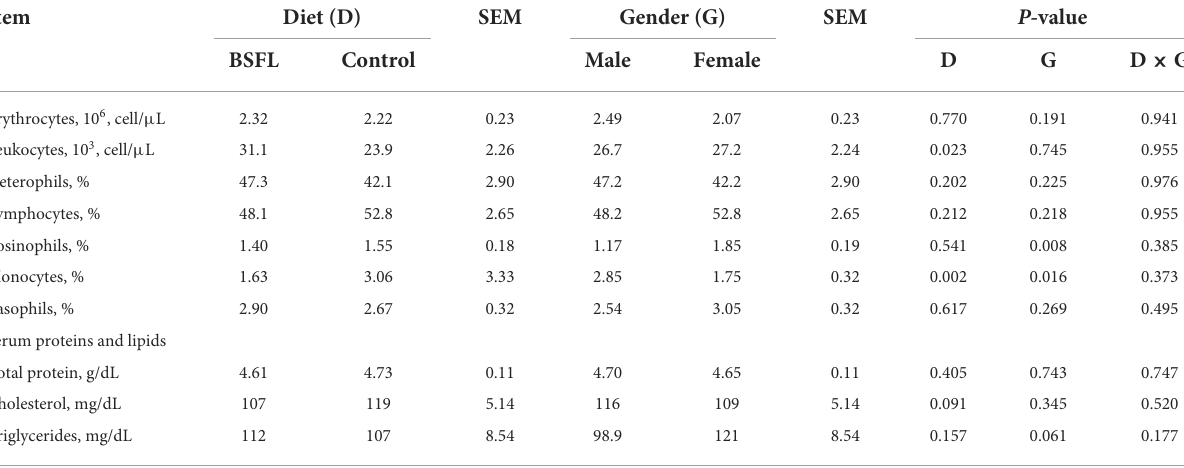
TABLE 5 The hematological traits and serum proteins and lipids of the male and female Label Rouge Naked Neck birds fed a diet supplemented with 10% live black soldier fly larvae; supplementation based on the expected daily feed intake (28–81d; n =